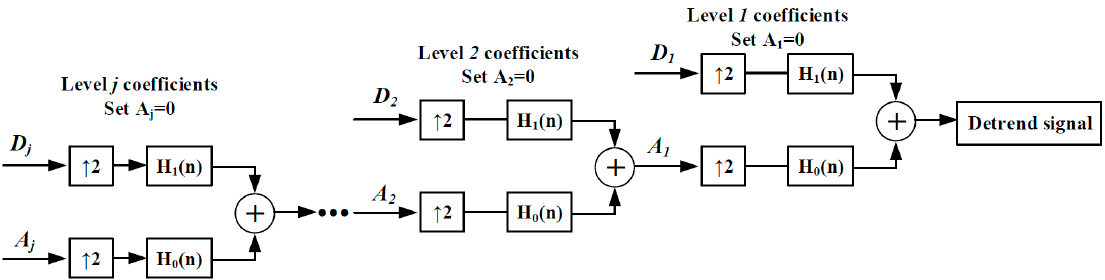
Figure 7. Discrete wavelet transform decomposition processing diagram.